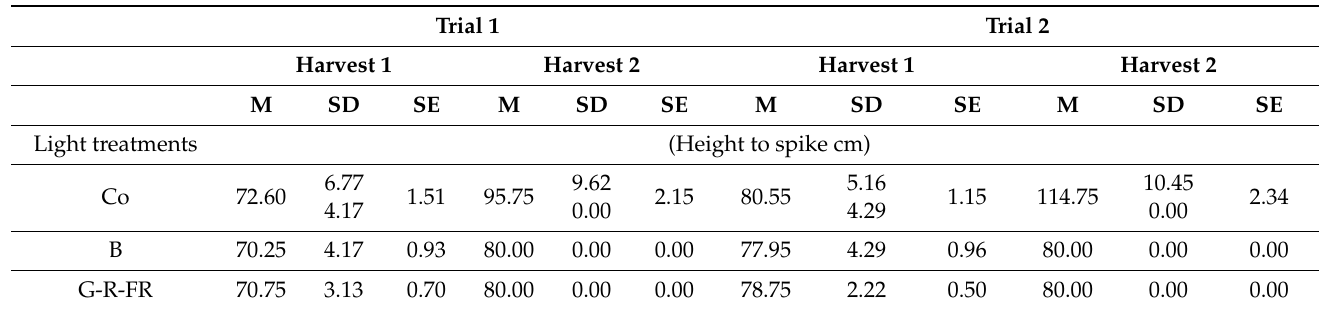
Table 2. Tenderstem ® height from the plant base, aboveground, to spike (cm) mean and standard deviation at each harvest. Co (control), B (blue), G-R-FR (green/red/far-red).